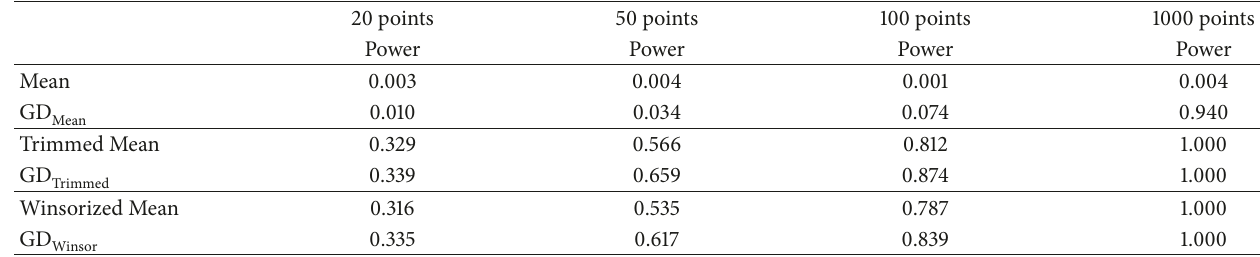
Table 53: Contaminated 𝜒 2 distributions with 50% noise level.